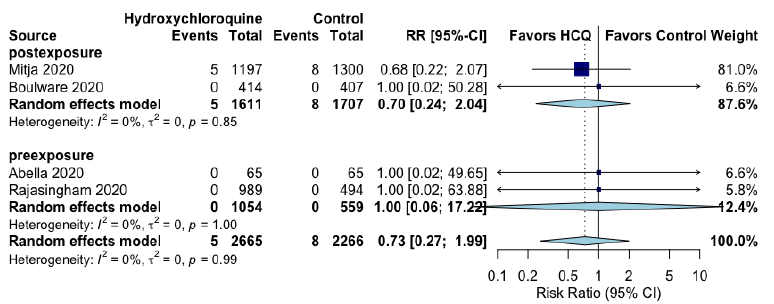
Figure 3. Effect of prophylaxis with hydroxychloroquine on all-cause mortality.